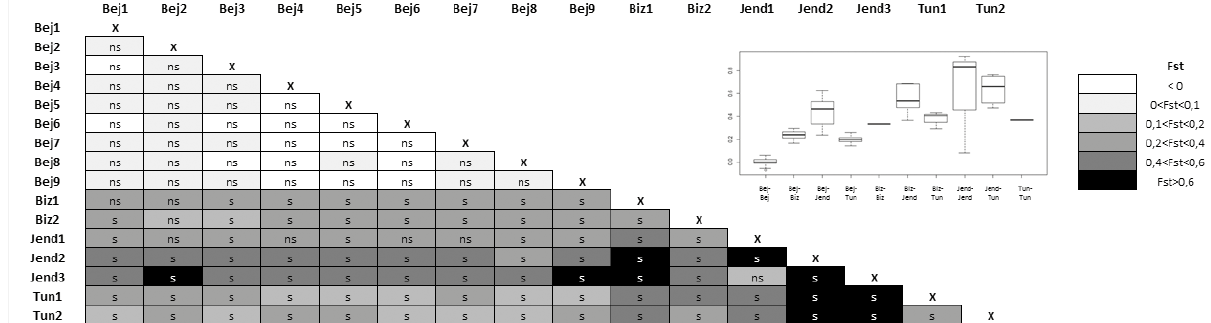
Figure 1. Matrix of pairwise F ST among Ascochyta fabae sub-populations sampled in 2012. “ns” indicates non-significant differentiation between two populations (p: sub-population) from different locations (Bej = Beja, Biz = Bizerte, Jend = Jendouba, Tun =: Tunis). The distri- bution of pairwise F ST s among each sub-population is indicated by the box plots.